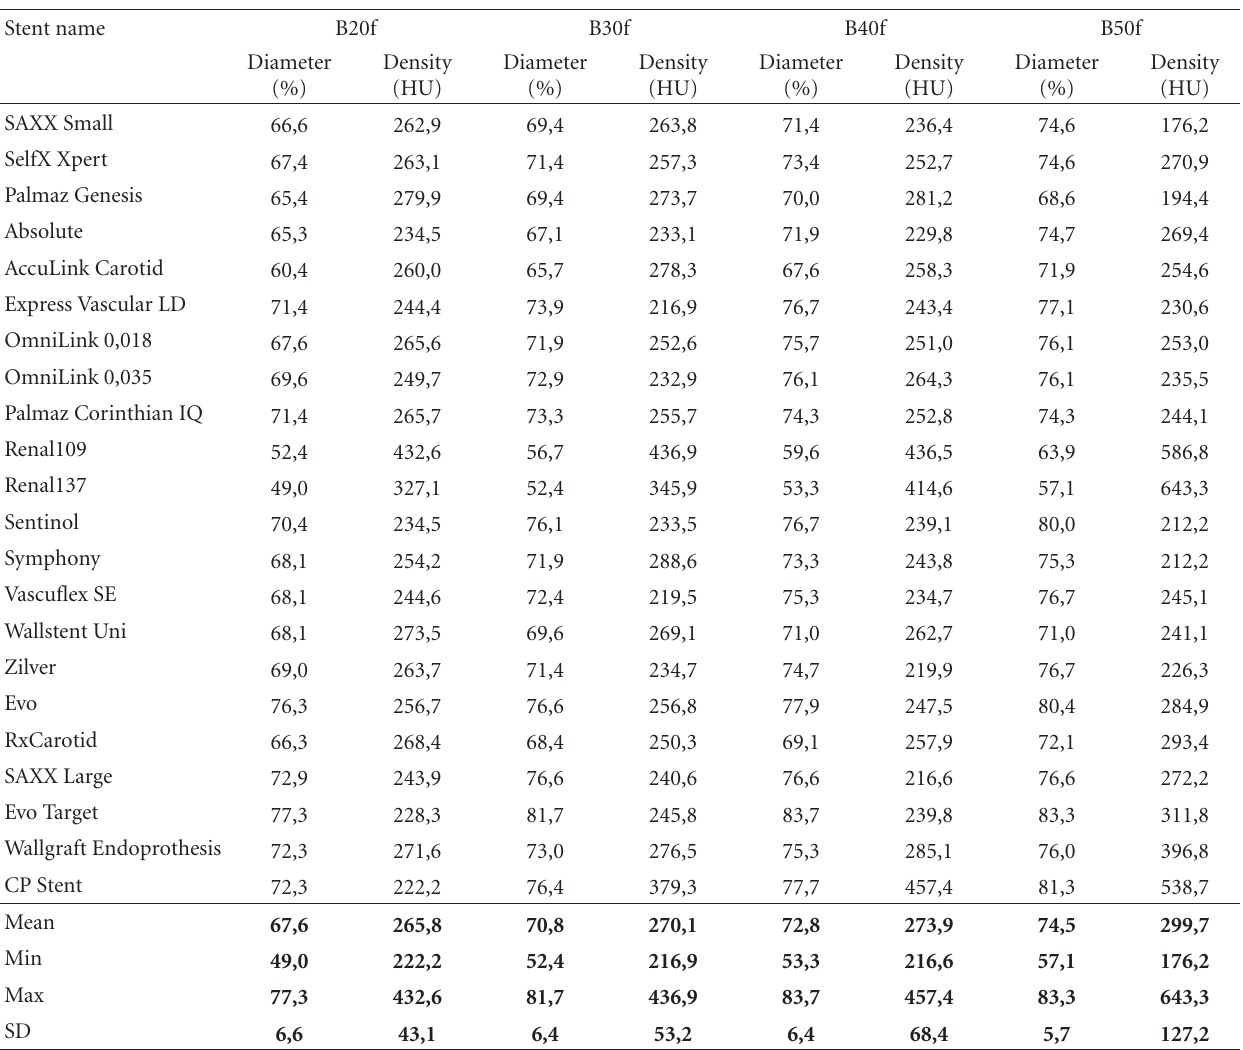
Table 2: Mean visible lumen diameters and intraluminal attenuation of the investigated stents using four di ff erent reconstruction kernels. Diameters of the visible stent lumen are given as mean (minimum/maximum) ± standard deviation in % of the actual lumen. Attenuation and noise values are given as mean (minimum/maximum) ± standard deviation in Hounsfield units (HUs).